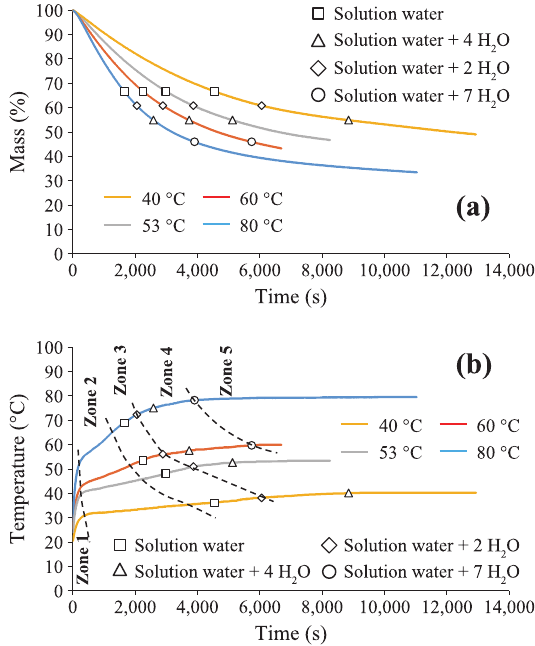
Fig. 15 Effect of the air temperature on the solution drying. Variation of (a) the mass and (b) the temperature of the sample surface during the treatment.